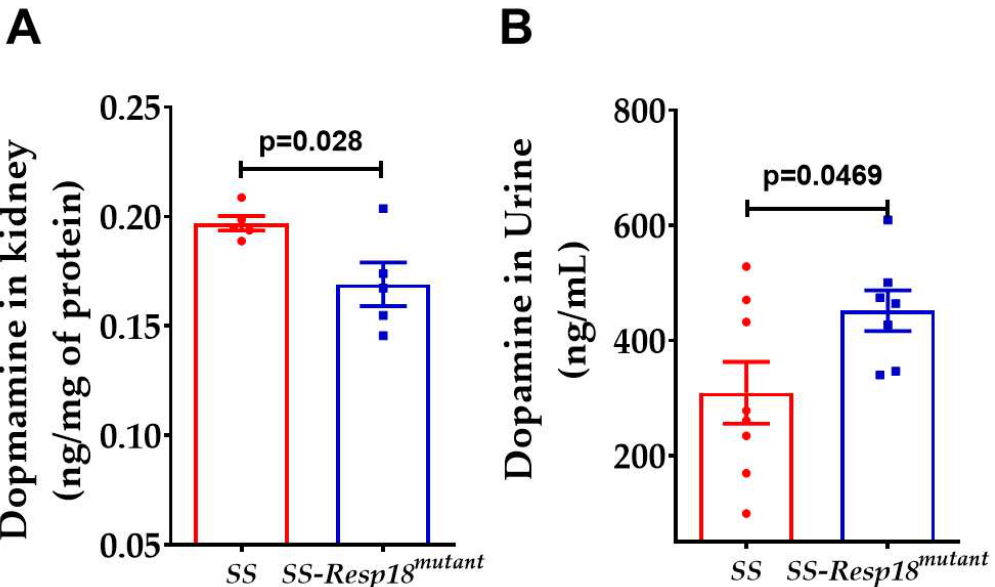
Figure 5. SS- Resp18 mutant rats have increased urinary dopamine: After six weeks of a high-salt diet, dopamine concentration was measured in the kidney ( n = 5/group) ( A ) and the urine ( n = 7–8/group) ( B ) of SS and SS- Resp18 mutant rats. Data are mean ± SEM. p = 0.028, p = 0.0469 vs. SS- Resp18 mutant rats, t -test.